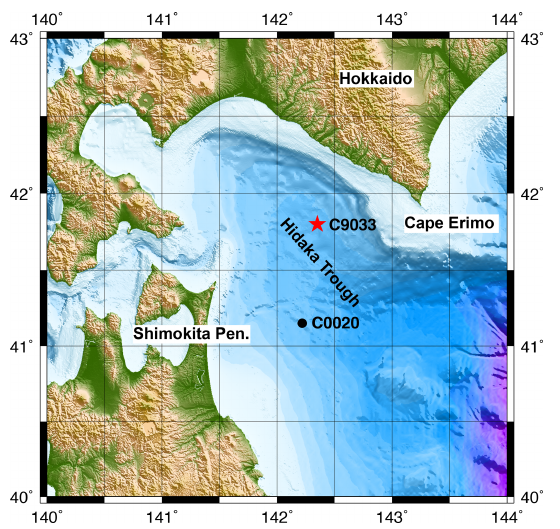
Figure 1. Site C9033 is located west off Cape Erimo, Hokkaido, northern Japan. The site is located 70km north of IODP Site